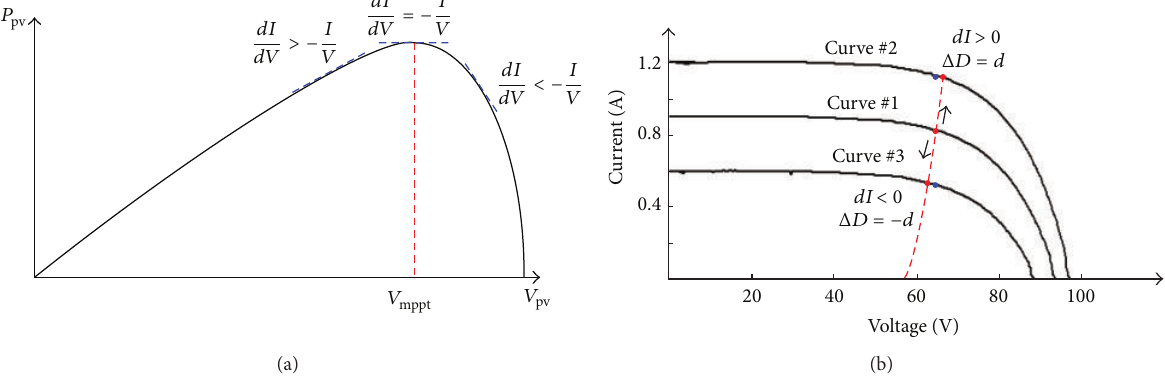
Figure 6: Judgment for the incremental conductance